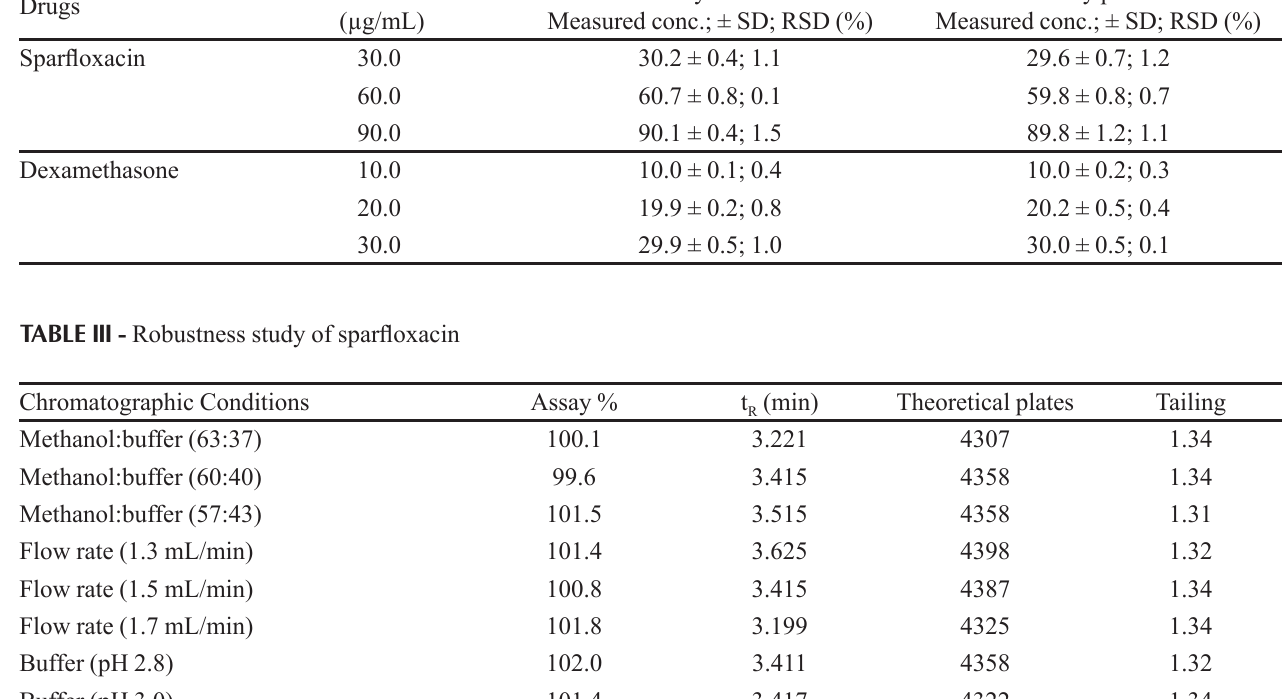
TABLE II - Intra-Day and Inter-Day Precision of the Proposed HPLC Method Drugs